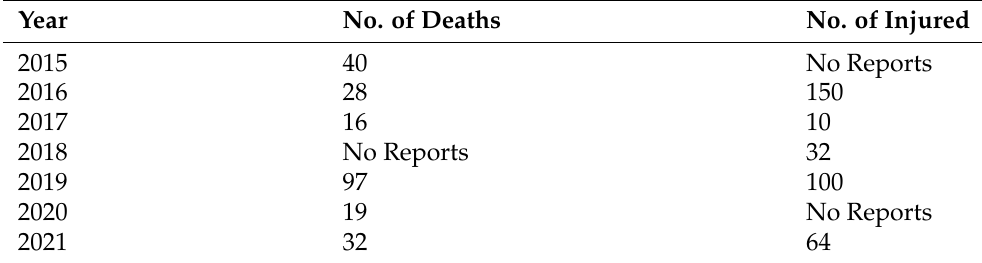
Table 1. Railway accidents stats in Pakistan